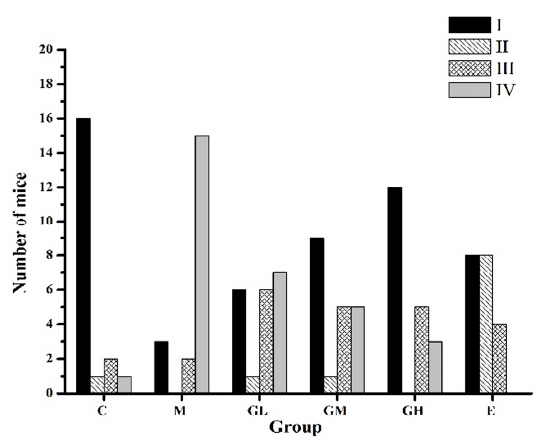
Figure 1. Effects of genistein on estrous cycle patterns of BALB/c female mice. Four patterns of abnormal estrous cycles were graded in an increasing order of abnormality (I–IV) as follows: I: normal; II: regular cycles with a shortened estrus; III: irregular cycles with a prolonged diestrus and normal or prolonged estrus; IV: no cyclicity. C: control group; M: model group; GL: low-dose of genistein (5 mg/kg body weight) therapeutic group; GM: moderate-dose of genistein (25 mg/kg body weight) therapeutic group; GH: high-dose of genistein (45 mg/kg body weight) therapeutic group; E: estradiol (1 mg/kg body weight) therapeutic group.